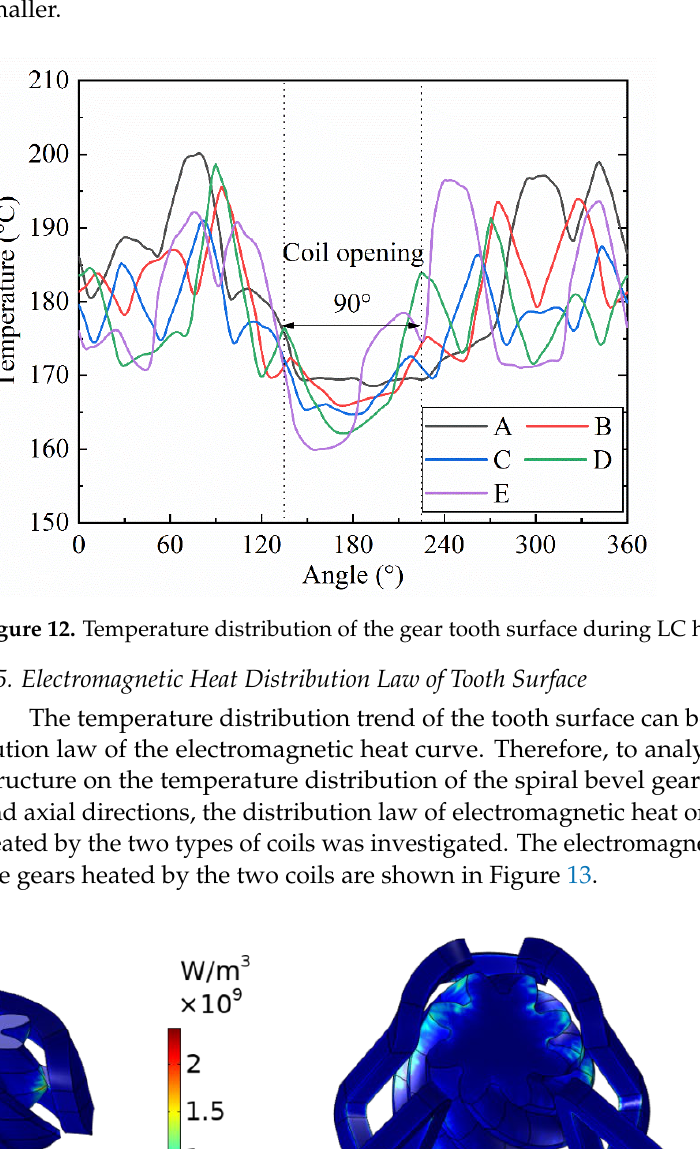
Figure 11. Temperature distribution of the gear tooth surface during TC heating.